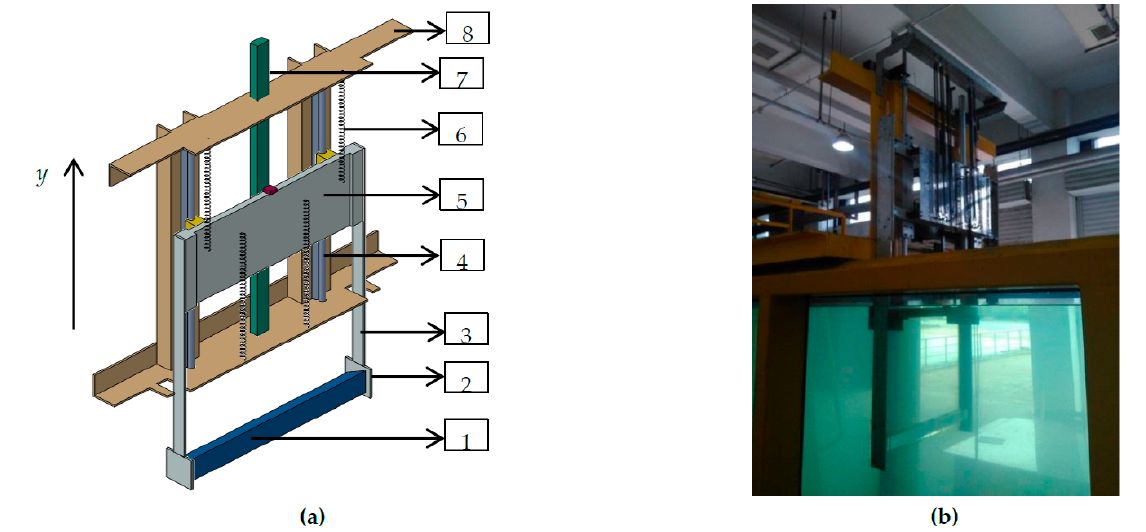
Figure 1. Vibration system with an equilateral triangle prism ( a ) Parts of vibration system; ( b ) Picture of vibration system.